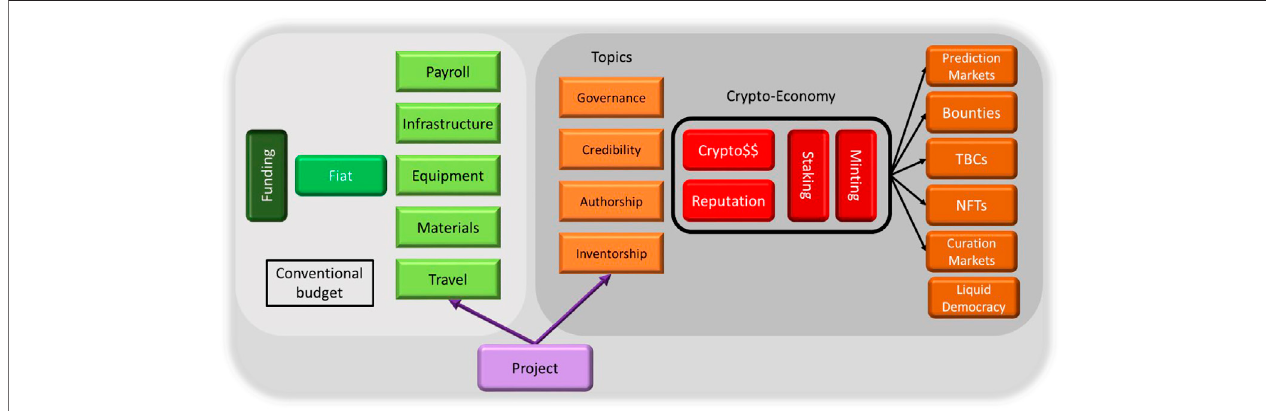
FIGURE 5 | Concept for grafting a blockchain-enabled project onto existing funding and budget schemes. In a two-pronged approach, real-world expenses and salaries are reimbursed by classical funding schemes in fi at money. Aspects of governance, credibility, author, and inventorship leverage a token economy revolving aroundmintingandstakingoftokensrepresentingcrypto-assetsandreputation.Thistokeneconomyoffersnovelinstrumentsforprojectoptimizationsuchasprediction andcurationmarkets,bountiesrewardedforidentifyingorsolvingparticularissues,tokenbondingcurves(TBCs)toincentivizethoroughassessmentofearly-stage ideas by skin-in-the-game, non-fungible tokens (NFTs), for example, for assigning contributions to IP and a liquid democracy – guided management structure. The portrayed strategy will seminally enhance project outcomes by comprehensive community involvement and increase motivation for